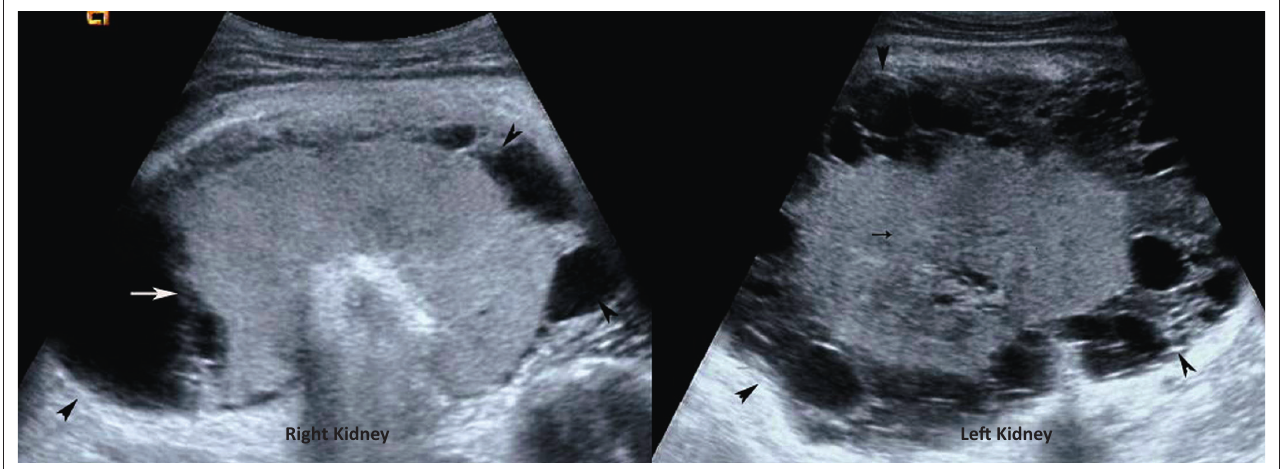
FIGURE 1: Sagittal US image of the kidneys. Bilateral multiseptated perinephric collection is noted (arrowheads). Corticomedullary differentiation is lost (solid black